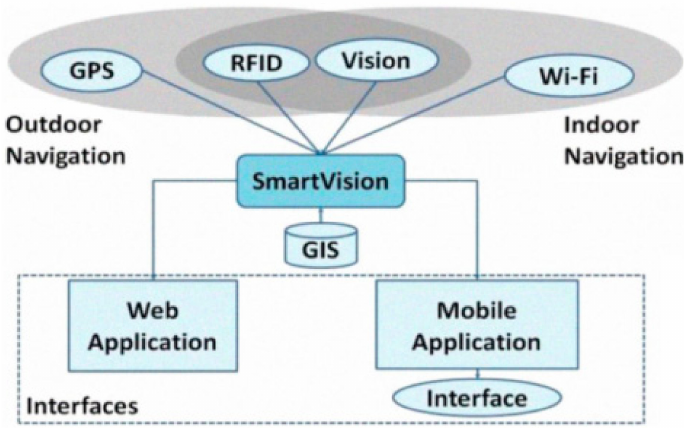
Figure 2. The SmartVision project: a schematic